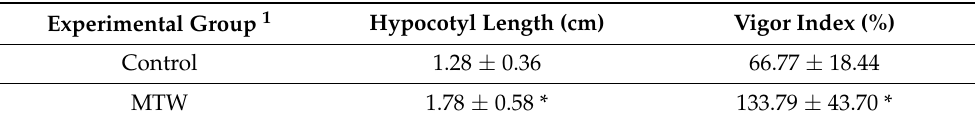
Table 1. Mean values of hypocotyl length and vigor index of Phaseolus vulgaris L. grown with magnetically treated